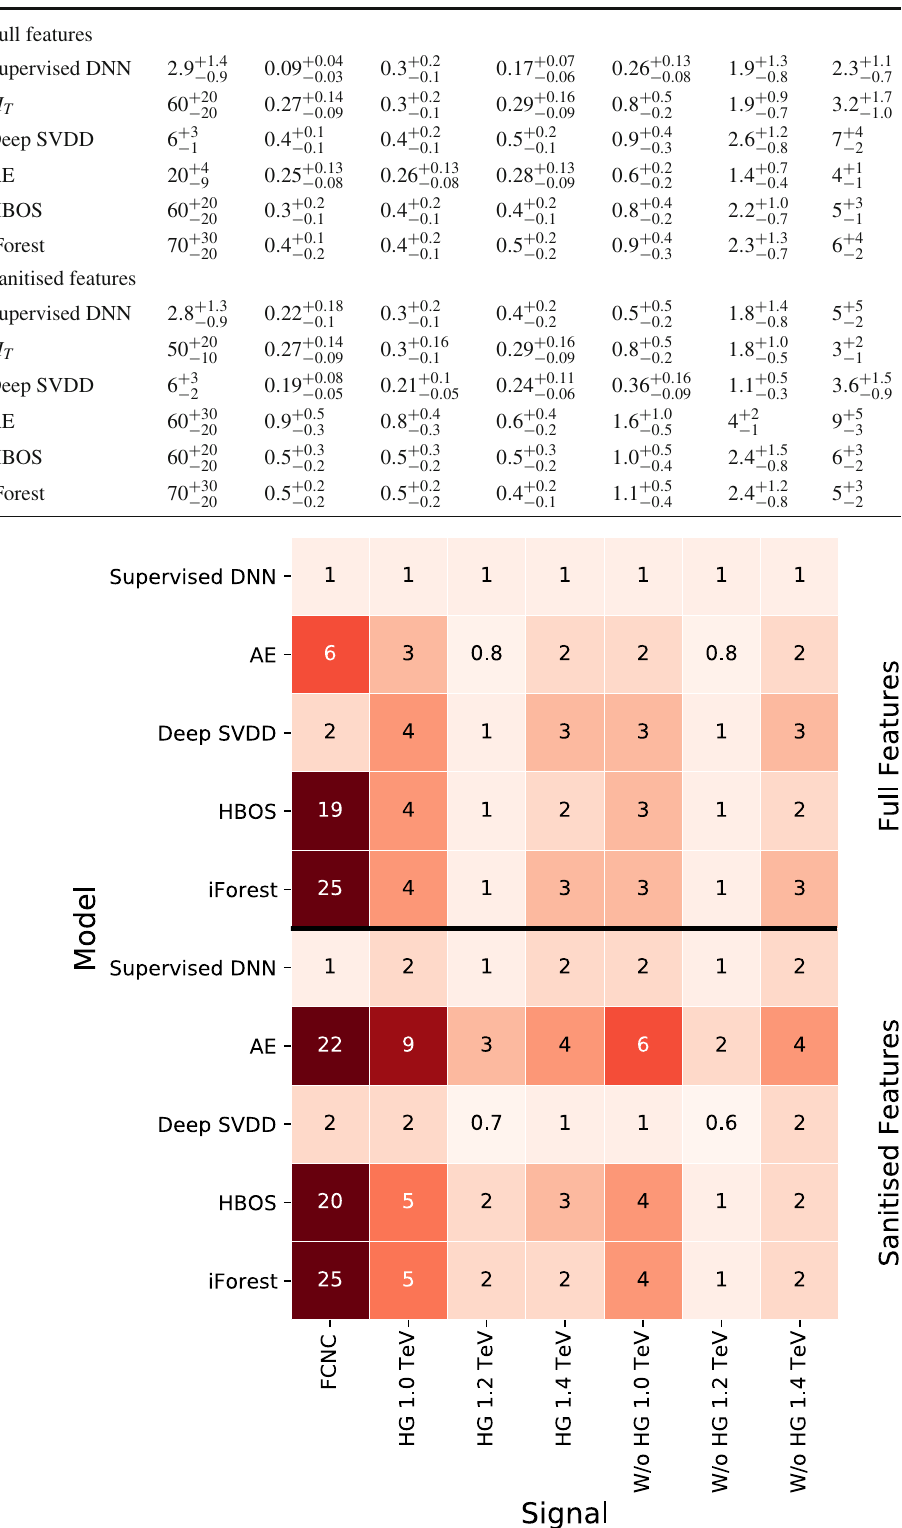
Table 1 95% CL upper limit on the signal strength µ of each benchmark signal for the different AD methods using the full feature set and the sanitised set and for a dedicated supervised DNN model trained on the full feature set. The statistical uncertainties, including the effect from limited statistics in the simulated datasets, are also shown